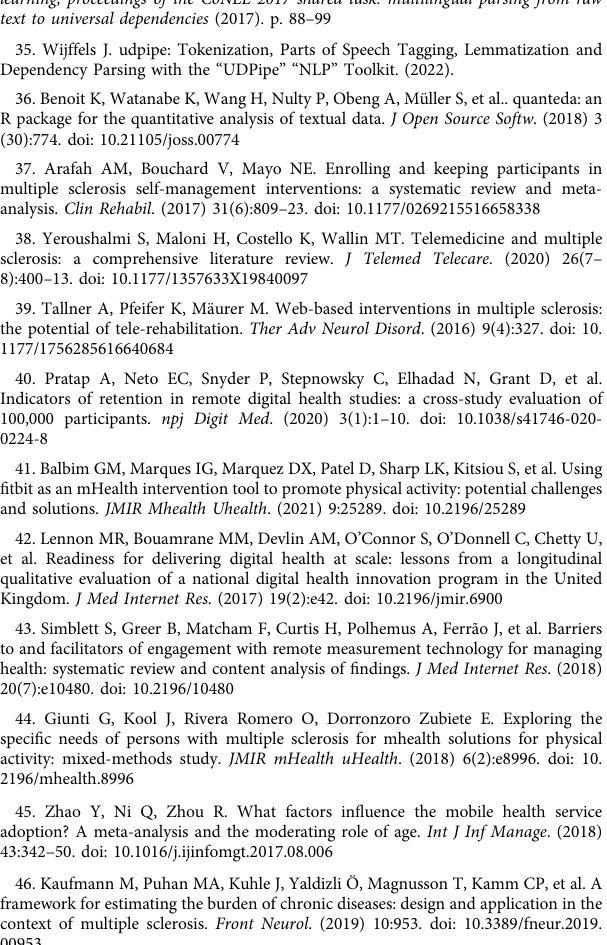
19: a protocol for a mixed-methods feasibility study. Int J Ther Rehabil . (2020) 27 (10):1 – 9. doi: